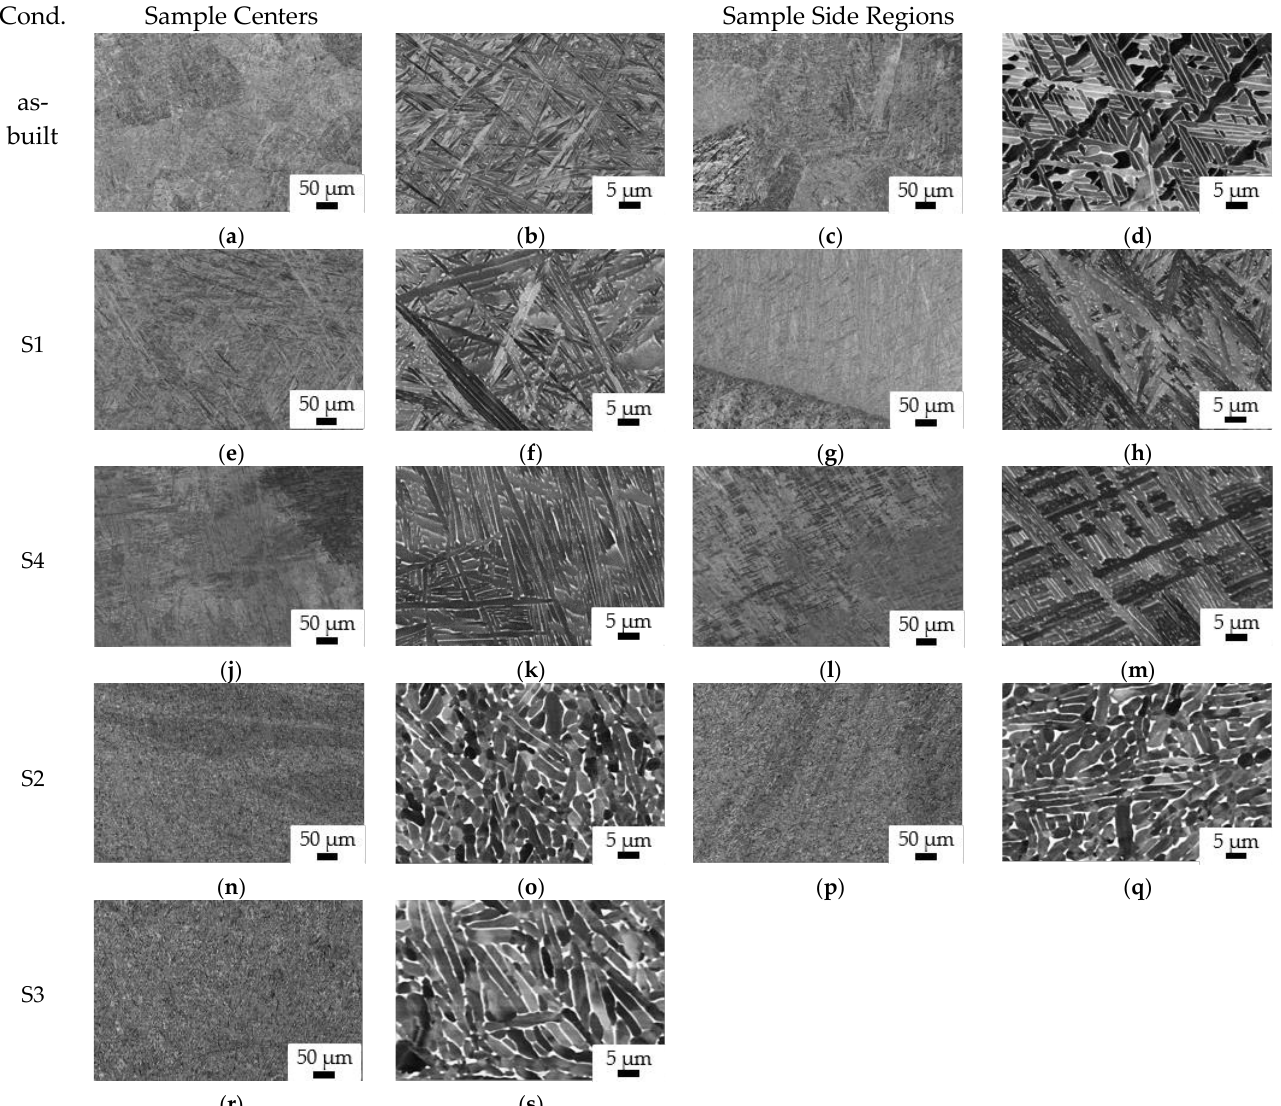
Figure 5. Microstructures of hot deformed samples, as visualized by BSE-SEM at magnifications of 500 × and 5000 × ; scale-bars are 50 µ m and 5 µ m, respectively. ( a – d ) For reference, micrographs of an un-deformed, as-built L-DED sample are shown. ( e – h ) Microstructures of alpha-beta forged and beta heat treated material (S1). ( i – l ) Microstructures of beta forged and stress relief annealed sample (S4). ( m – p ) Microstructures after alpha-beta forging to 50% compression (S2), and to 25–30% compression (S3) ( q – r ), respectively, both followed by stress relief annealing heat